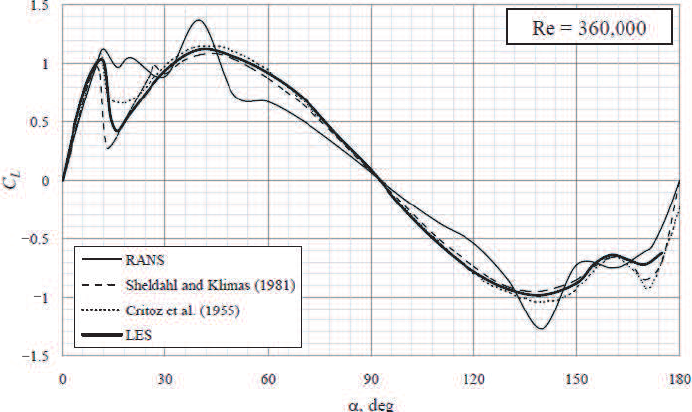
Figure 16. Lift as a function of AOA at Re = 3.6 × 10 5